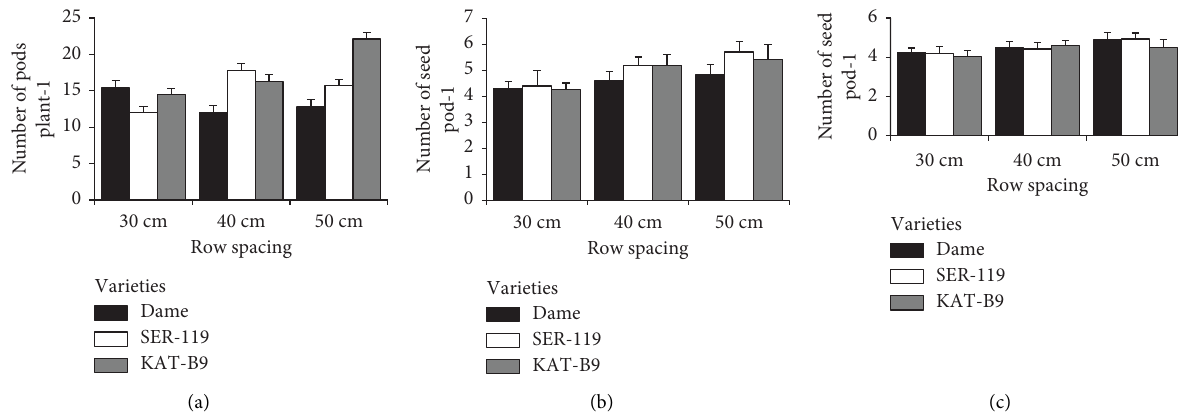
Figure 3: Interaction efect of inter-row spacing × varieties. (a) Number of pods plant − 1 at Arsi Negele; (b) number of seeds pod − 1 at Arsi Negele; and (c) number of seeds pod − 1 at